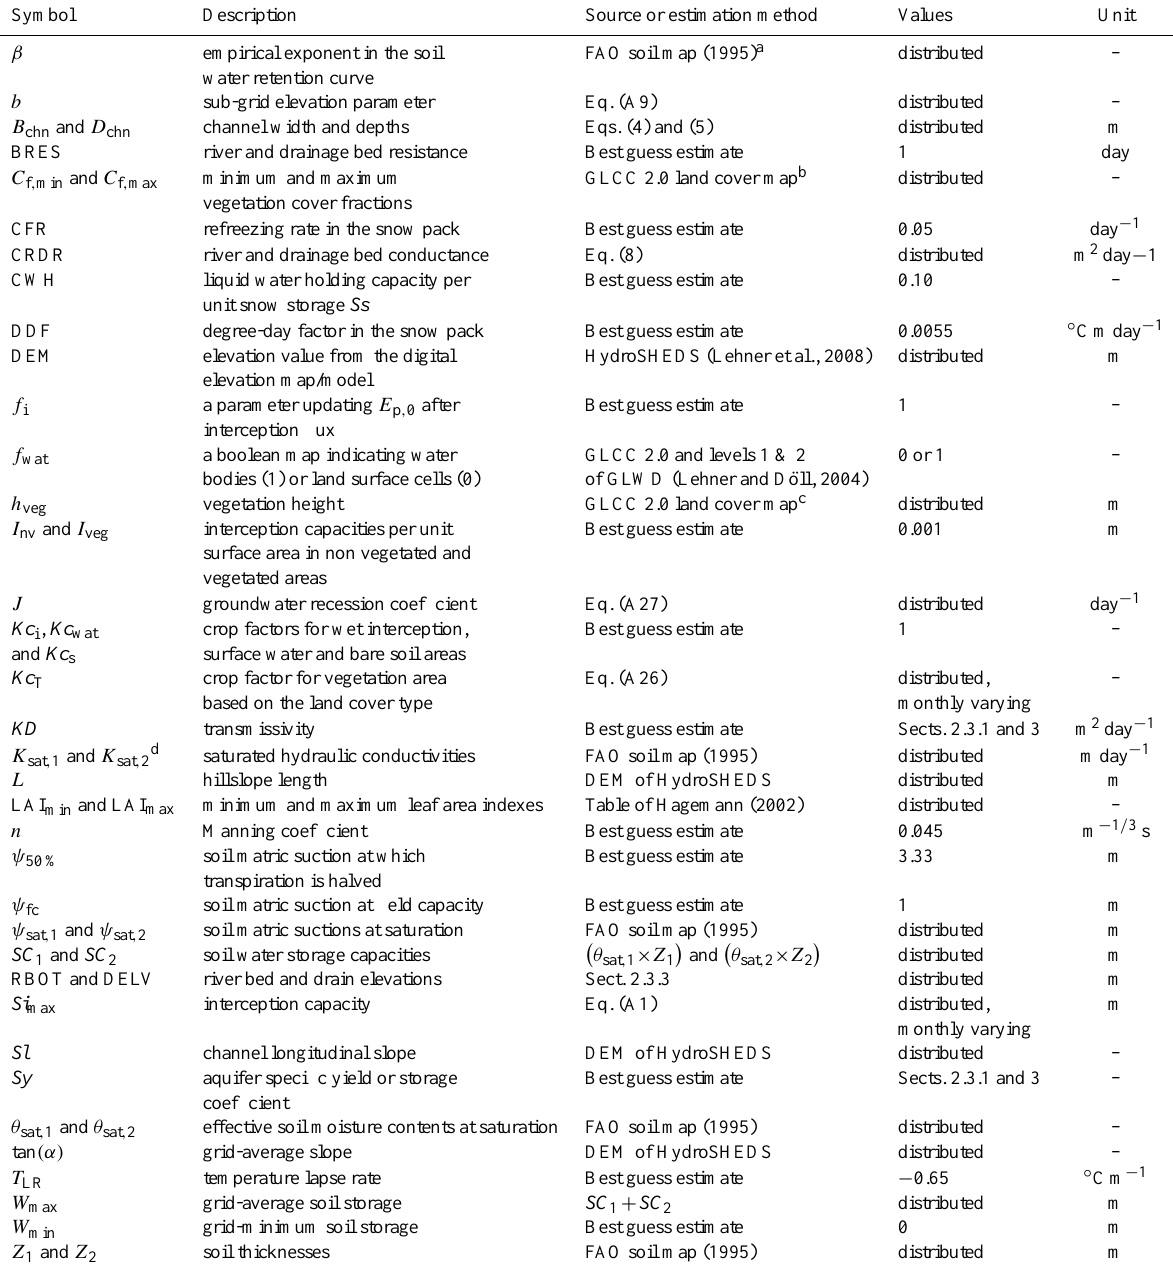
a The parameterization of FAO map (1995) based on Table of Van Beek and Bierkens (2009). b The parameterization of GLCC 2.0 land cover map based on Table of Hagemann (2002). c The parameterization of the vegetation height h veg based on Table of Van Beek (2008). d The subscripts 1 and 2 indicate the first and second soil